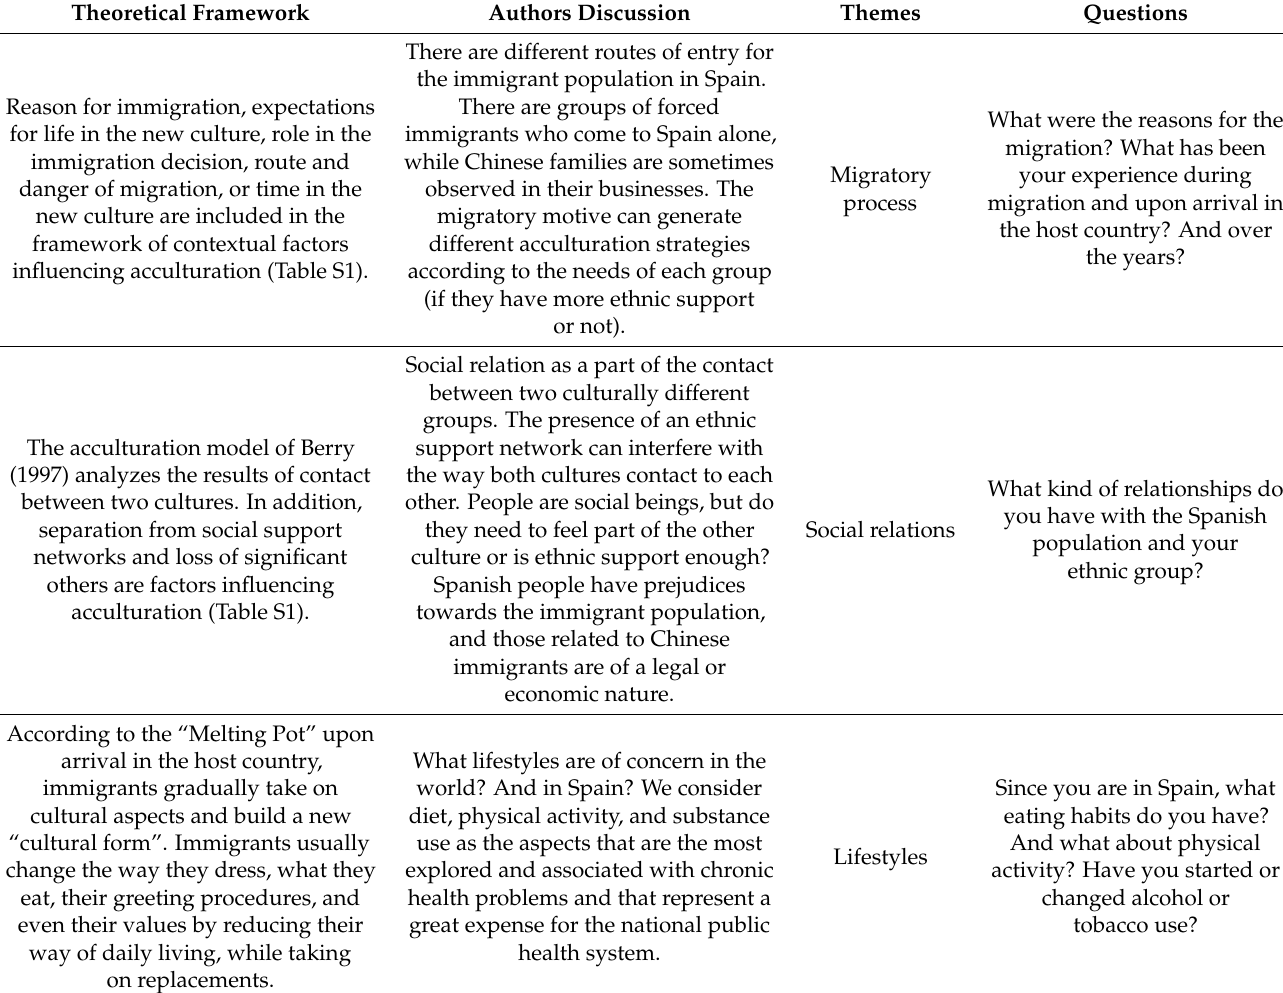
Table 1. Development of the interview